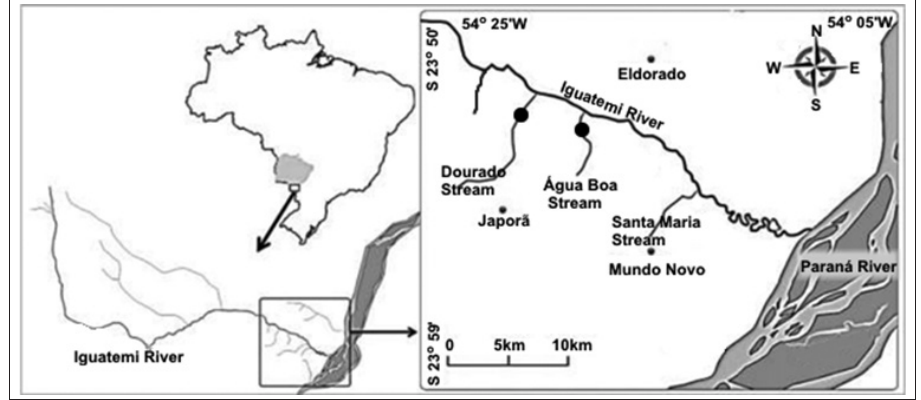
Figure 1. Localization of the Água Boa and Dourado streams from Iguatemi River Basin where specimens were captured. Dark circles indicate the sampled points.